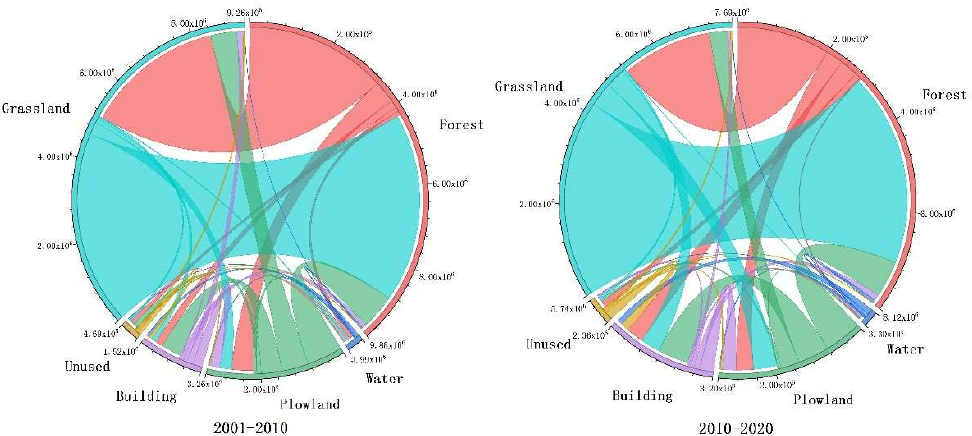
Figure 6. Chord diagram of land use type conversion from 2001 to 2020.